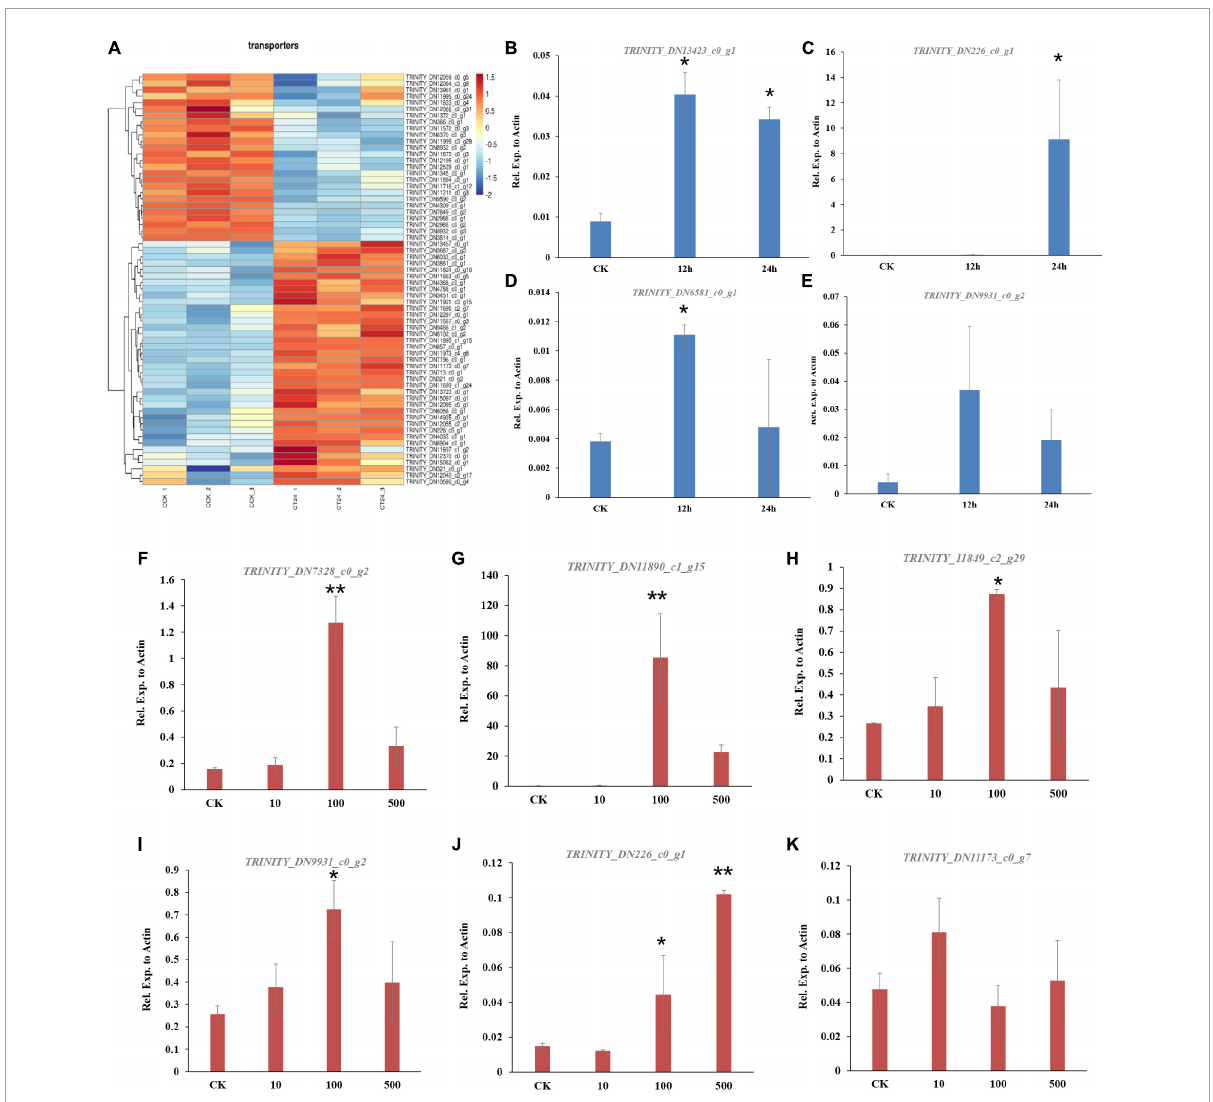
FIGURE2 Genes encoding transporters are enriched in C. camelliae CCA during infection tea plant. (A) Heatmap of differentially expressed genes encoding transporters. (B–E) qPCR analysis of selected transporter genes in C. camelliae during infection tea plant. (F–K) PCR analysis of selected transporter genes in C. camelliae upon caffeine treatments. Different concentration of caffeine (CK: 0, 10, 100, and 500 µ g/ml) was used to treat C. camelliae. All data were normalized to the expression of CcActin . Error bars represent SD of three biological replicates. Asterisks indicate significant differences between treatment and CK (* p < 0.05; ** p <